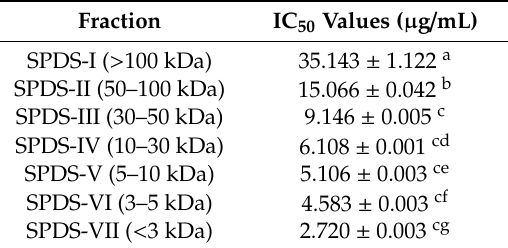
Table 1. Results of IC 50 values of fractions from sesame protein digestive solution (SPDS) on ACE inhibitory